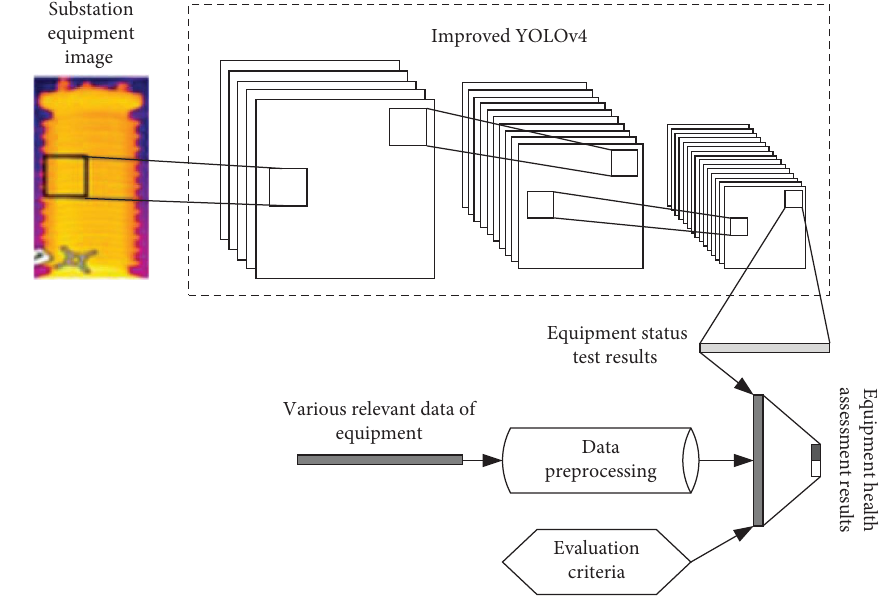
Figure 6: Panoramic assessment process of substation equipment health status. Table 1: Health state criteria of electrothermal